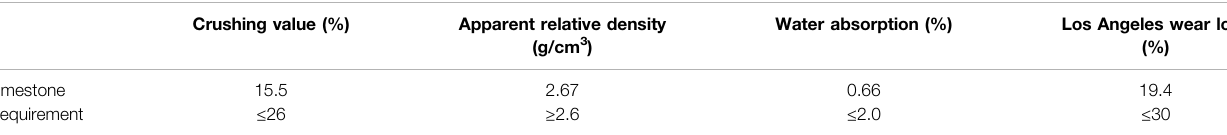
TABLE 2 | Physical index of stone.